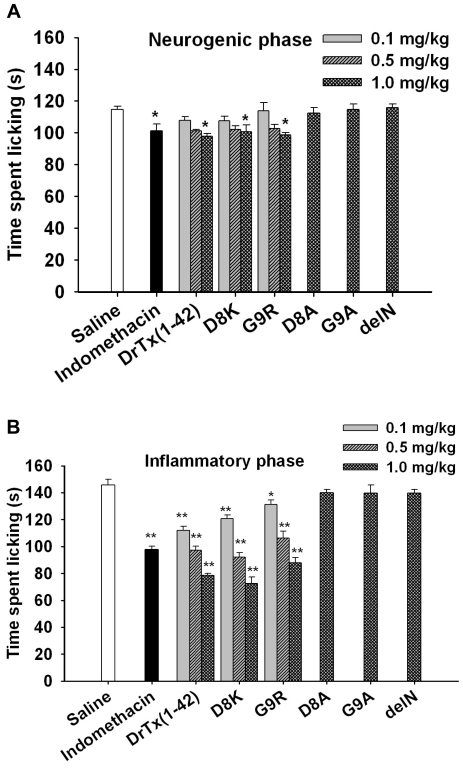
Effects of DTX(1-42) and its mutants on the time spent licking during the neurogenic (A) and inflammatory (B) phases of the formalin test in mice.The y-axis represents the time spent licking in sec during neurogenic and inflammatory phases. Data are reported as mean ± SEM for n = 8 per group. One-way ANOVA followed by Student Newman Keuls post hoc test. *: P<0.05, **: P<0.01 compared to vehicle-treated group (saline).